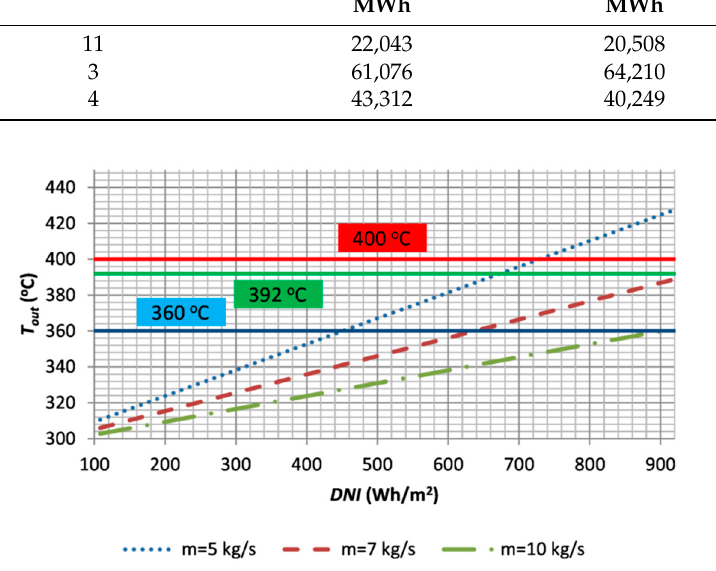
Figure 8. Medium temperature in the absorber at the outlet of a single loop as a function of mass flow and solar radiation (calculations performed for the conditions in Cordoba).